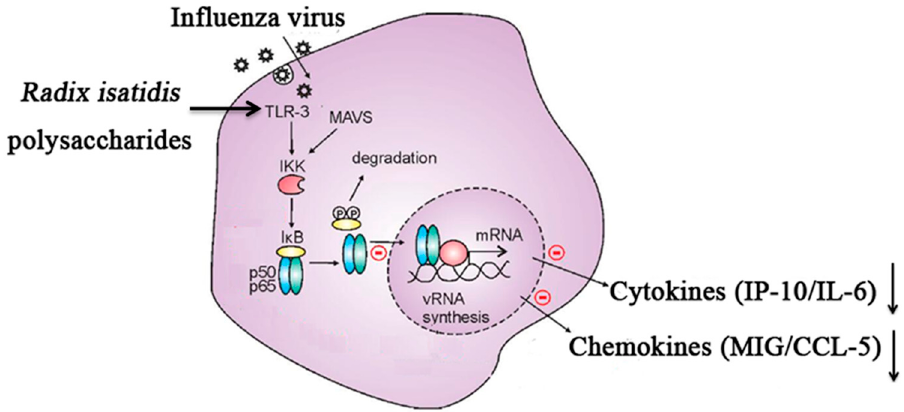
Figure 4. Schematic diagram of the mechanism of suppression of influenza virus-induced inflammation by Radix isatidis polysaccharides.